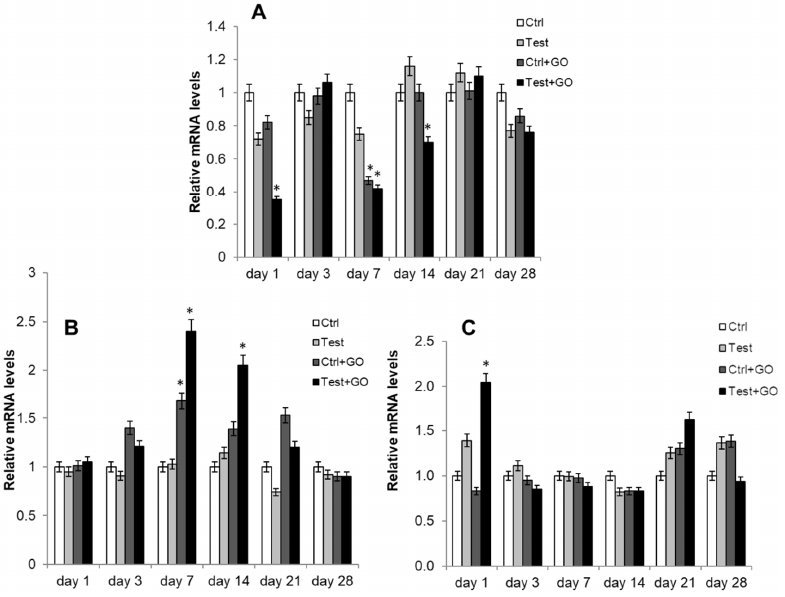
Figure 9. Relative gene expression of ( A ) RUNX2, ( B ) SP7, and ( C ) COL1A1 in DPSCs cultured on Ti discs for 1, 3, 7, 14, 21, and 28 days. Data are expressed as relative to control (calibrator sample, defined as 1). Values represent the means ± SD. Y -axis, fold change. The most representative of three separate experiments is shown. *RUNX2, day 1: test + GO vs. control, test, control + GO p < 0.05; day 7: control + GO vs. control p < 0.05, test + GO vs. control p < 0.05; day 14: test + GO vs. control, test, control + GO p < 0.05. *SP7, day 7: control + GO, vs. control, test p < 0.01; test + GO vs. control, test p < 0.01; day 14: test + GO vs. control, test p < 0.01. *COL1A1, day 1: test + GO vs. control, test p <